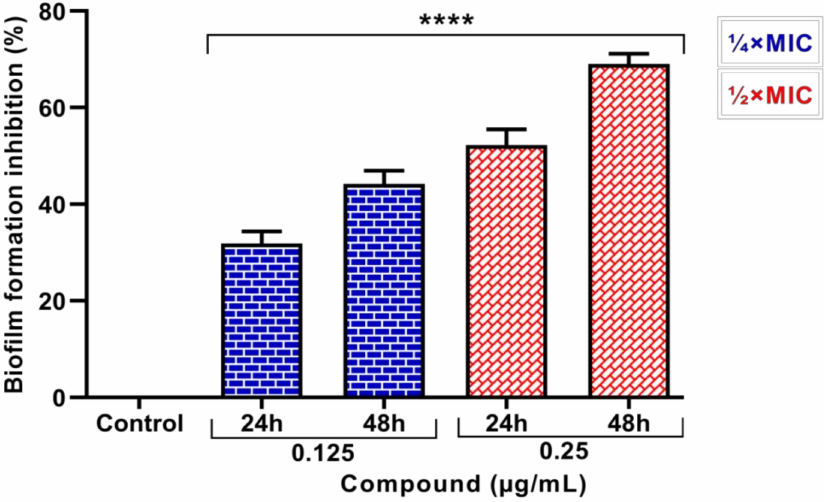
Figure 12. Effect of Ag-Cu bimetallic NPs on biofilm formation by C. albicans . The cells were treated with 1 / 4 × MIC and 1 / 2 × MIC under biofilm growing conditions. Untreated cells (control) presents as 0% inhibition in biofilm formation, whereas inhibition was recorded in exposed cells. **** p value <